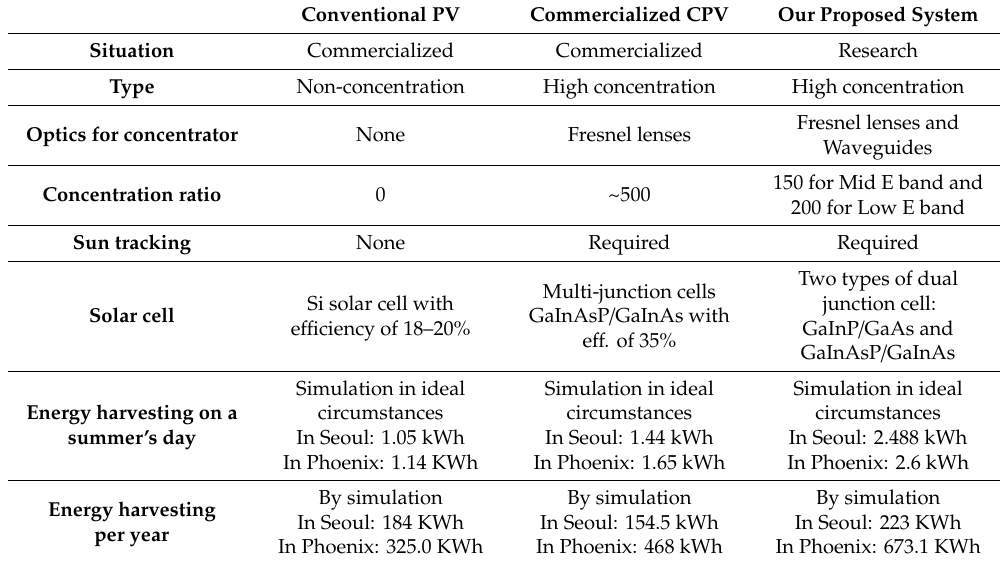
Table 3. Comparison in performance between conventional photovoltaic (PV) systems, CPV systems, and our proposed